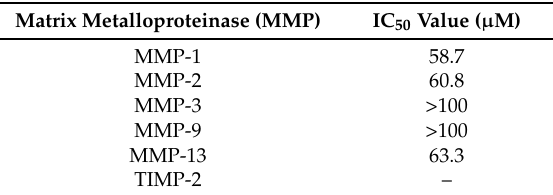
Table 1. IC 50 value of pseudoshikonin I on the activity of MMP-1, 2, 3, 9, and 13 in IL-1 β -induced SW1353 cells a .